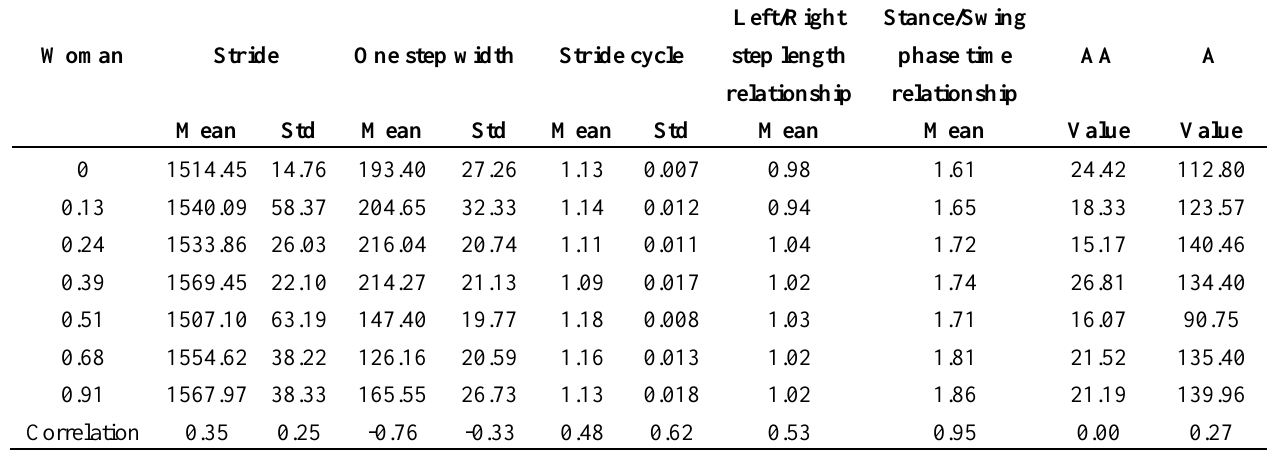
Table 5. Gait parameters relative to alcohol intake: Woman case.